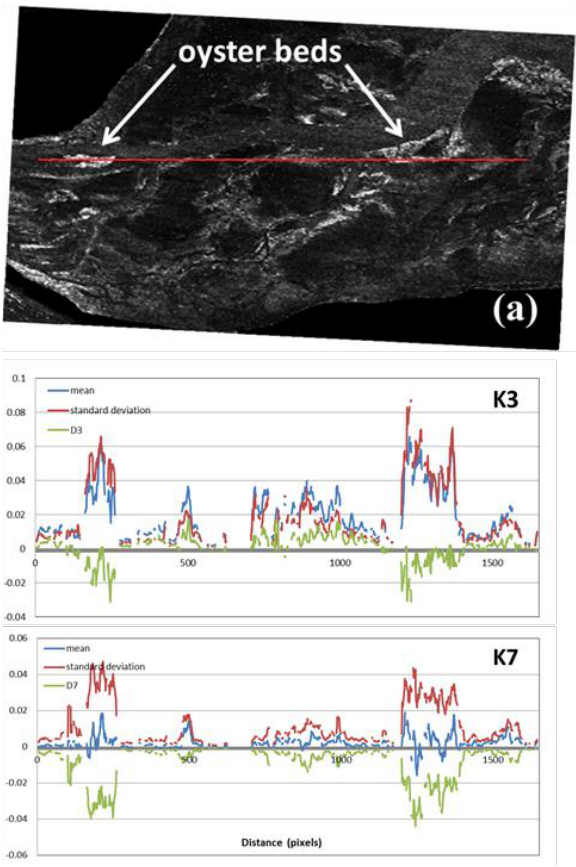
Figure 5. Transects along the red lines in Figure 3. (a) total image intensity (rotated for better comparison with the curves below); (b) 11-pixels running mean (blue), standard deviation (red), and difference of both (green) for the Kennaugh element K 3 ; (c) the same for K 7